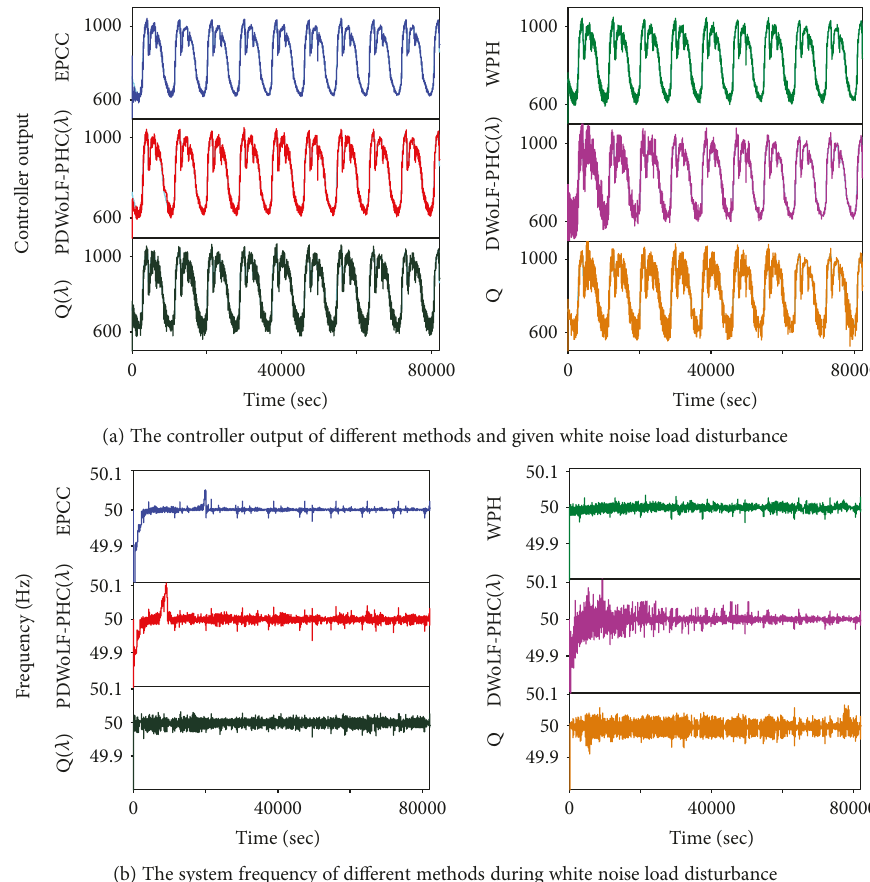
Figure 11: The control performance of di ff erent methods during white noise load disturbance.